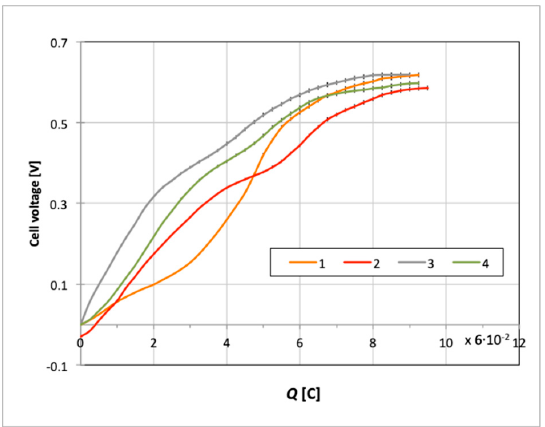
Figure 7. Influence of anodic charge on the catalytic activity of Cu–B alloy containing 6% of B.